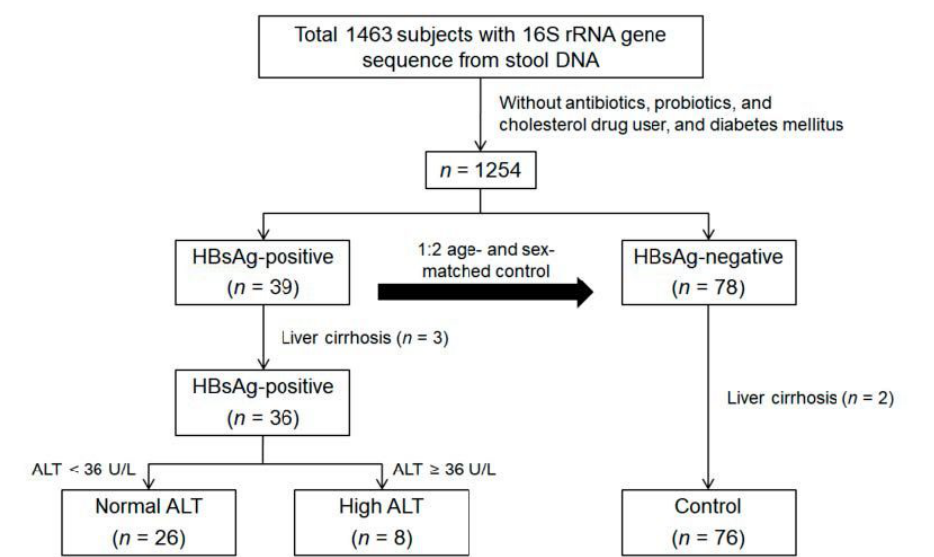
Figure 1. Flow chart of the study subjects. ALT: alanine aminotransferase; HBsAg: hepatitis B surface